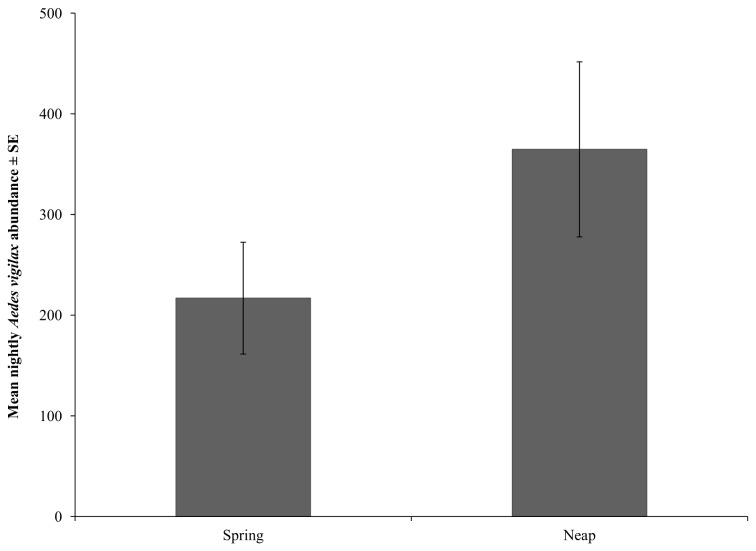
Nightly Aedes vigilax abundance.
Aedes vigilax abundance during spring and neap tides.